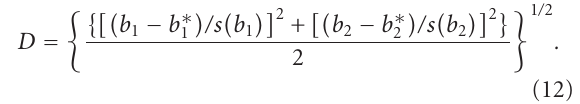
Figure 1. (a) Univariable synthesis method—e ff ect of perturb- ing R on partial regression coe ffi cients. The x -axis represents the perturbation; the y -axis represents the change in the regression coe ffi cient in standardized distance between the perturbed and unperturbed models. (b) Univariable synthesis method—e ff ect of perturbing R on correlations. The x -axis represents the per- turbation; the y -axis represents the correlation between the pre- dicted values for the perturbed and unperturbed